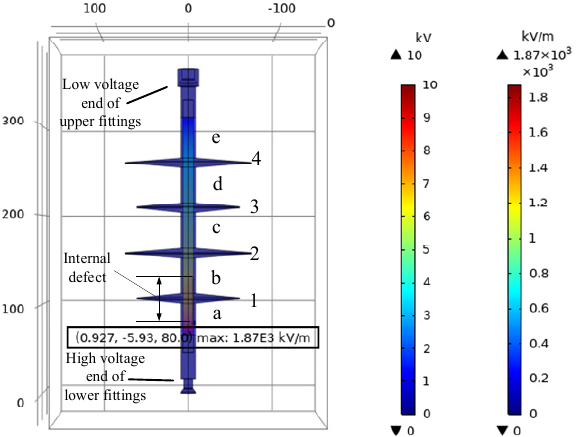
Figure 5. Calculation model of the composite insulators with internal defects: ( a ) between “ a ”–“ b ”; ( b ) between “ d ”–“ e ”; ( c ) the internal defect model.